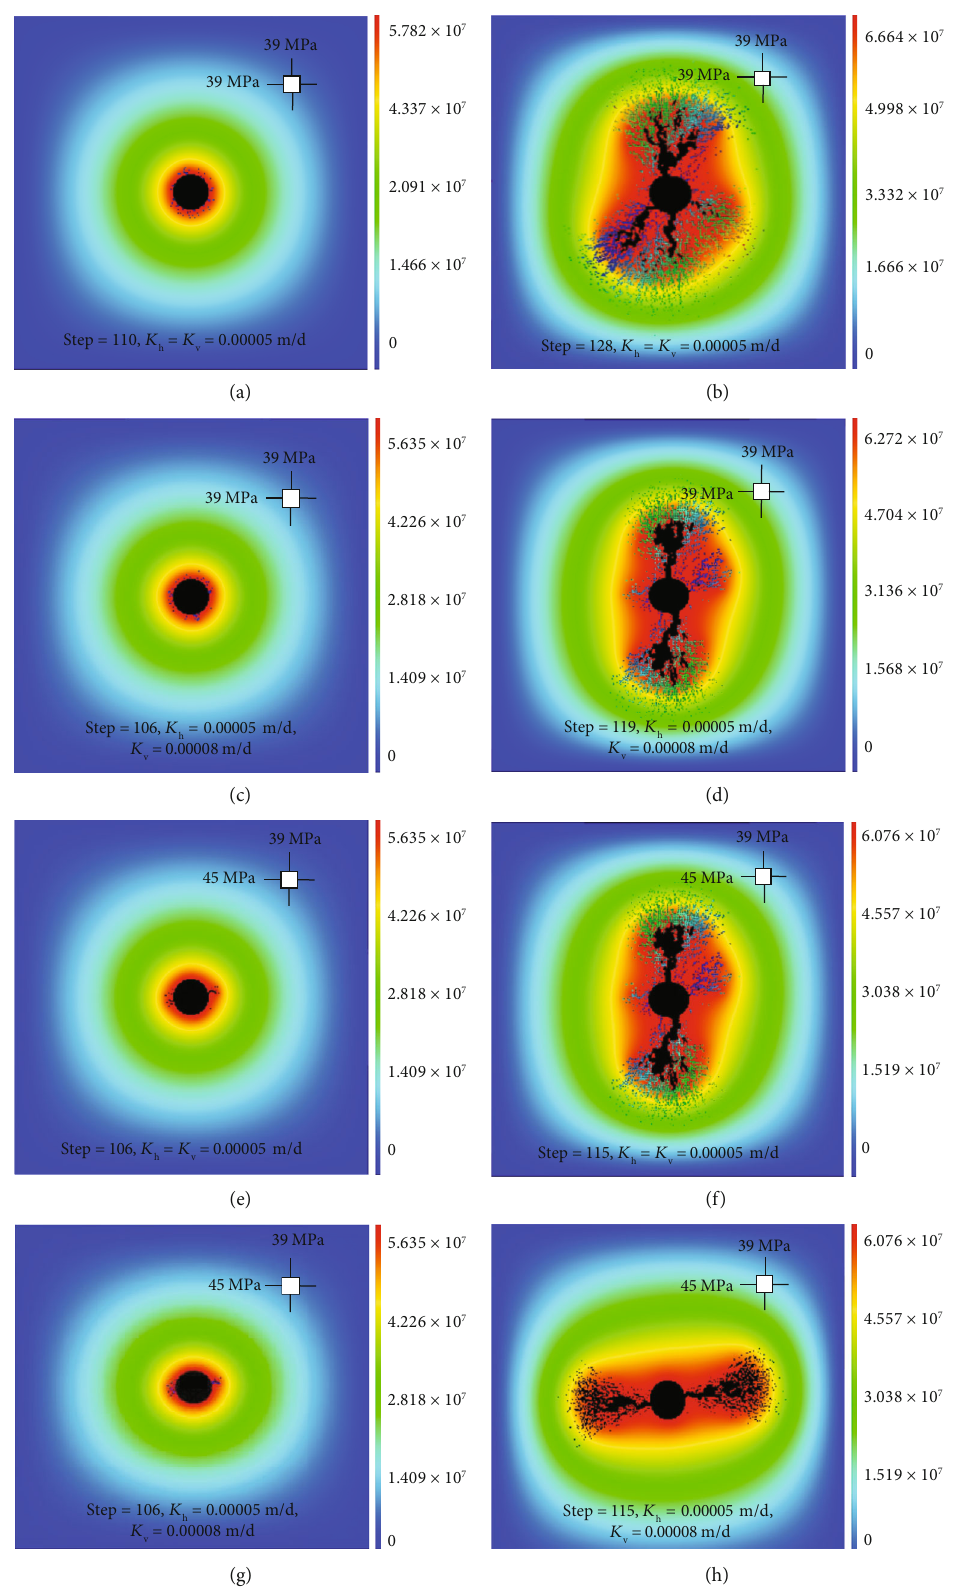
Figure 5: E ff ect of the permeability coe ffi cient on HF morphologies at di ff erent stress di ff erence models without BP. The color shadow indicates the relative magnitude of the pore water pressure fi eld ( K vertical permeability coe ffi cient of the